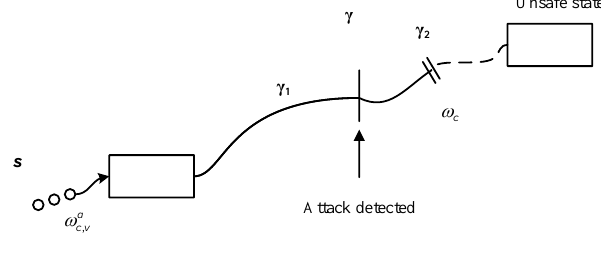
Figure 8. Graphic representation of AE-safe